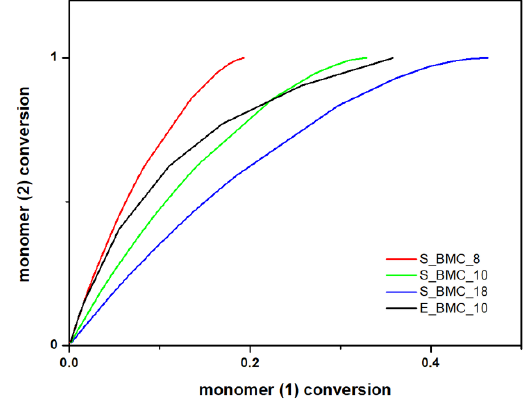
Figure 11. DLL simulation and experimental data of the conversion of 1,10-decanodiol versus the conversion of the DMC.